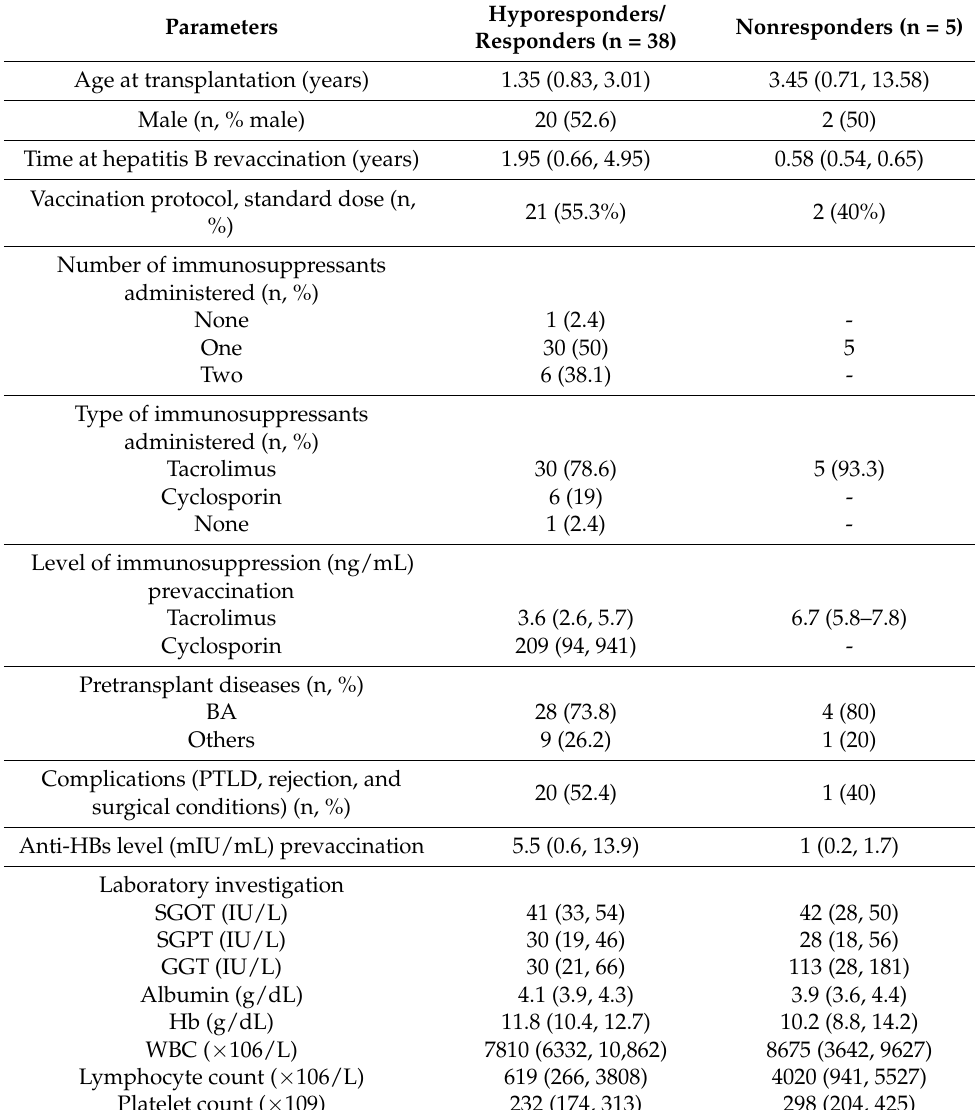
Table 4. The characteristics and laboratory data between hyporesponders/responders and nonre-